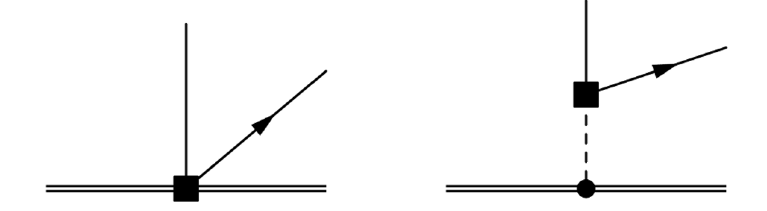
Figure 1 . Tree-level contributions to n ! pe (cid:0) (cid:23) , in the presence of non-standard vector, axial, scalar, pseudoscalar, and tensor currents. Nucleons and pions are denoted by double and dashed lines, the electron by a single line with an arrow, while (cid:23) , which is a Majorana mass eigenstate, by a single line (with no de(cid:12)nite particle (cid:13)ow). The insertion of the non-standard current is denoted by a square, while strong-interaction vertices by a circle. In the case of the vector, scalar, and tensor currents, only the (cid:12)rst topology appears because parity forbids the couplings of the current to a single pion. Both diagrams contribute to the axial current at LO, while the pseudoscalar current is dominated by the pion pole in the second